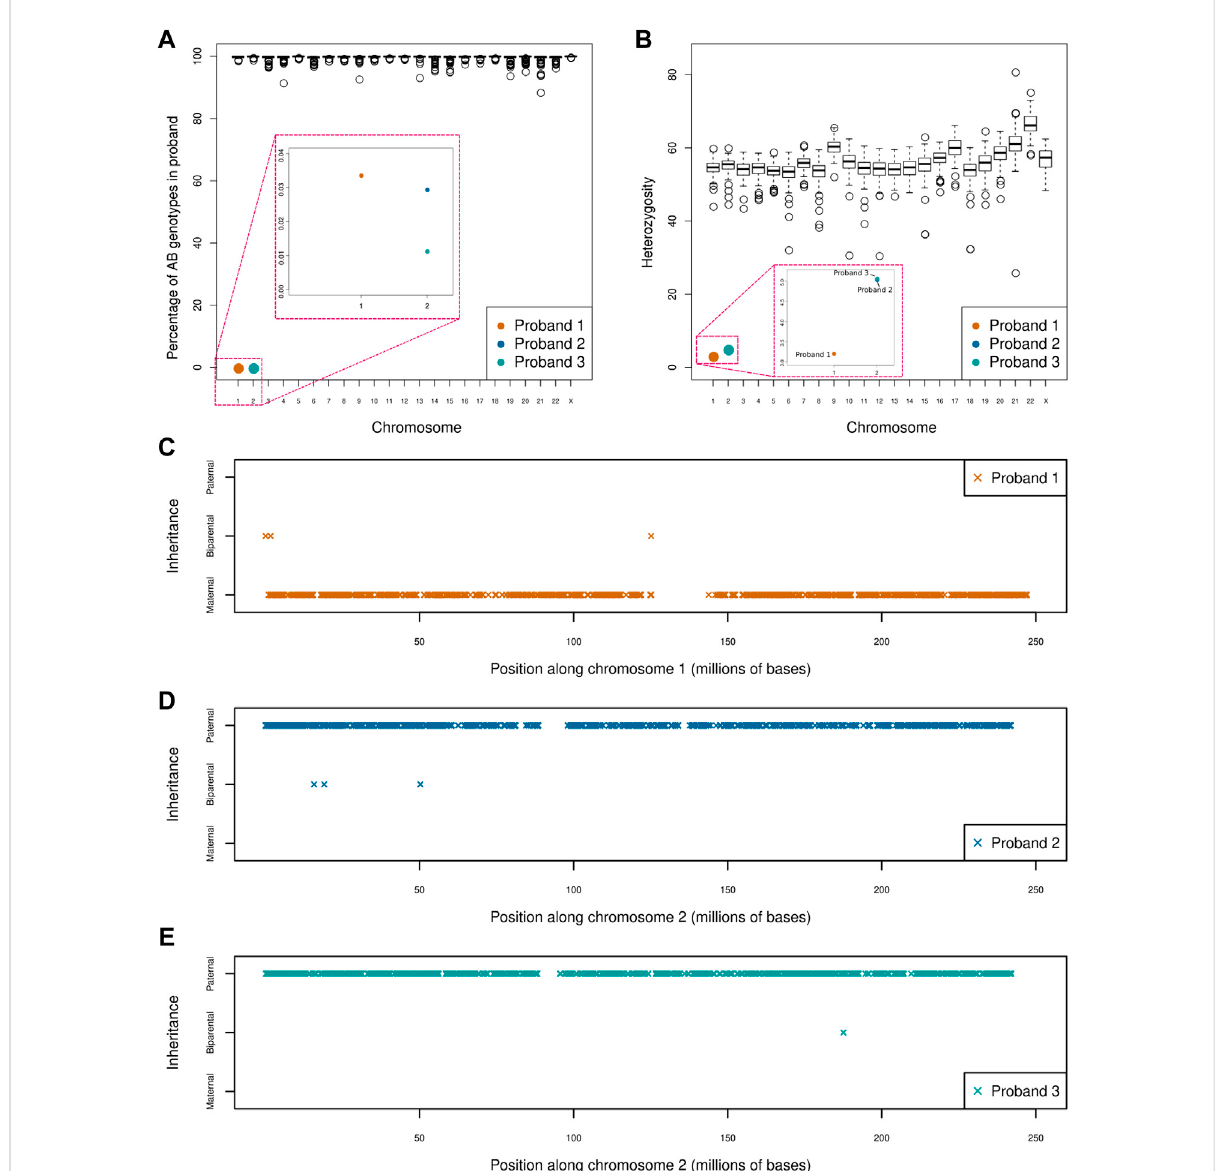
FIGURE 1 Uniparental disomy screen of 164 parent-child trios (A) Boxplot shows the percentage of AB genotypes in each child (represented by circles) when one parent has an AA genotype and the other parent has a BB genotype across each chromosome. The boxes in red indicate a zoom of that region of the plot for ease of visualisation. Three clear outliers can be seen affecting chromosome 1 (P1) and chromosome 2 (P2 and P3). Large regionsofapparentMendelianerroracrosssinglechromosomes(e.g.,inchromosomes4,9,and14)wereidenti fi ed.Anassessmentofcoverage across these regions con fi rmed these events to be a consequence of inherited or de novo deletions rather than partial UPD events. One of the large deletionshadpreviouslybeenidenti fi edbychromosomalmicroarray (B) Boxplotshowsthepercentageheterozygosityacrosseachchromosomefor every proband (C – E) Shows the direction and extent of disomy in P1 (C) , P2 (D) and P3 (E) . Proband 1 shows maternal isodisomy of chromosome 1with99.97%ofgenotypesmatchingthatofthemother,whileproband2and3exhibitspaternalisodisomyofchromosome2with99.99and99.97% of genotypes matching those of the father, respectively. This indicates that all three UPiD events affect the whole chromosome (these small deviationsfrom100%wereattributedtosequencingandgenotypecallingerrors).Onlygenotypeswheretheparentswerehomozygousfordifferent alleles were used in this